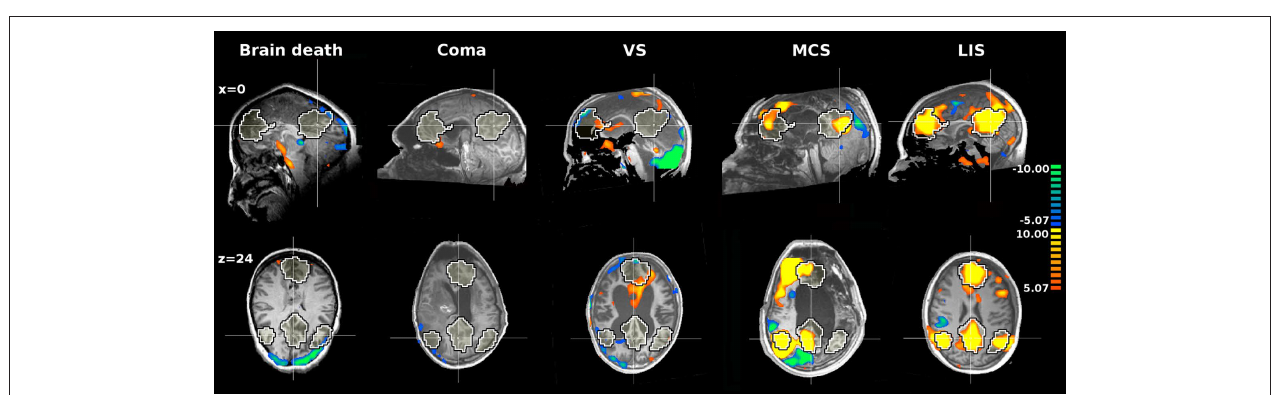
FIguRE 1 | The internal network of a healthy subject awake, under mild sedation and after loss of consciousness. The network was extracted with ICA. The black and white contour represents a template of the internal network extracted from 11 awake healthy subjects with ICA. Yellow and orange colors represent the areas which activities positively correlate with